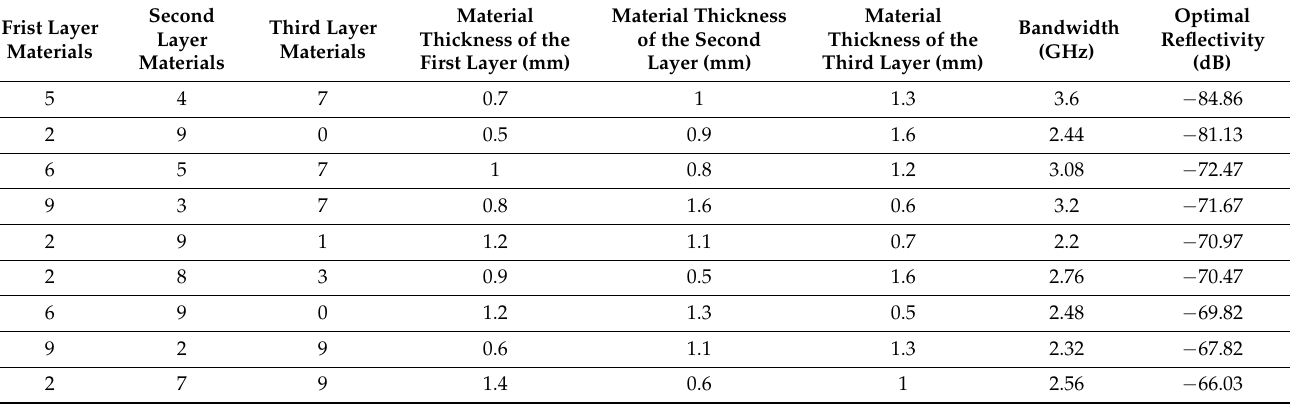
Table 9. The optimization results using objective function F2 (three-layers) of ABC algorithm. Second Frist Layer Materials